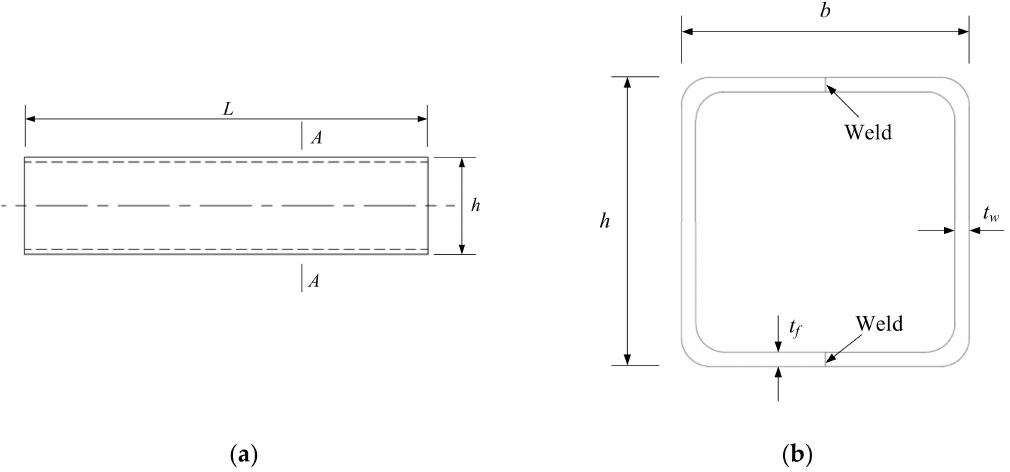
Figure 6. Drawings of samples. ( a ) Layout of the samples ( b ) Section A-A. Table 4. Butt size parameters of the cross-section